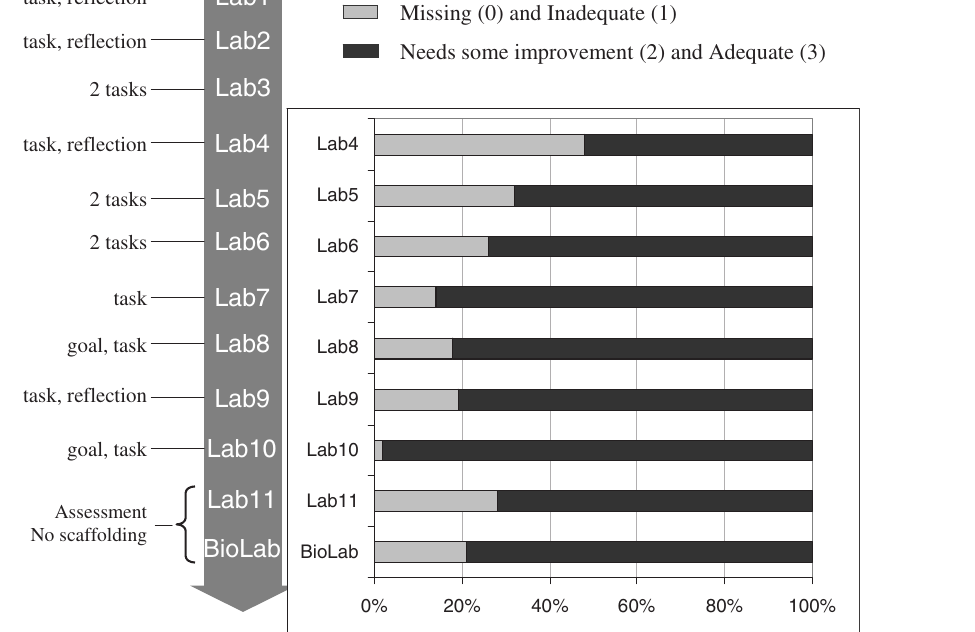
FIG. 6. Ability to compare two values and to make a judgment about the results of the experi- ment. The shaded bars represent the percentage of the students whose laboratory reports received scores shown at the top of the figure.